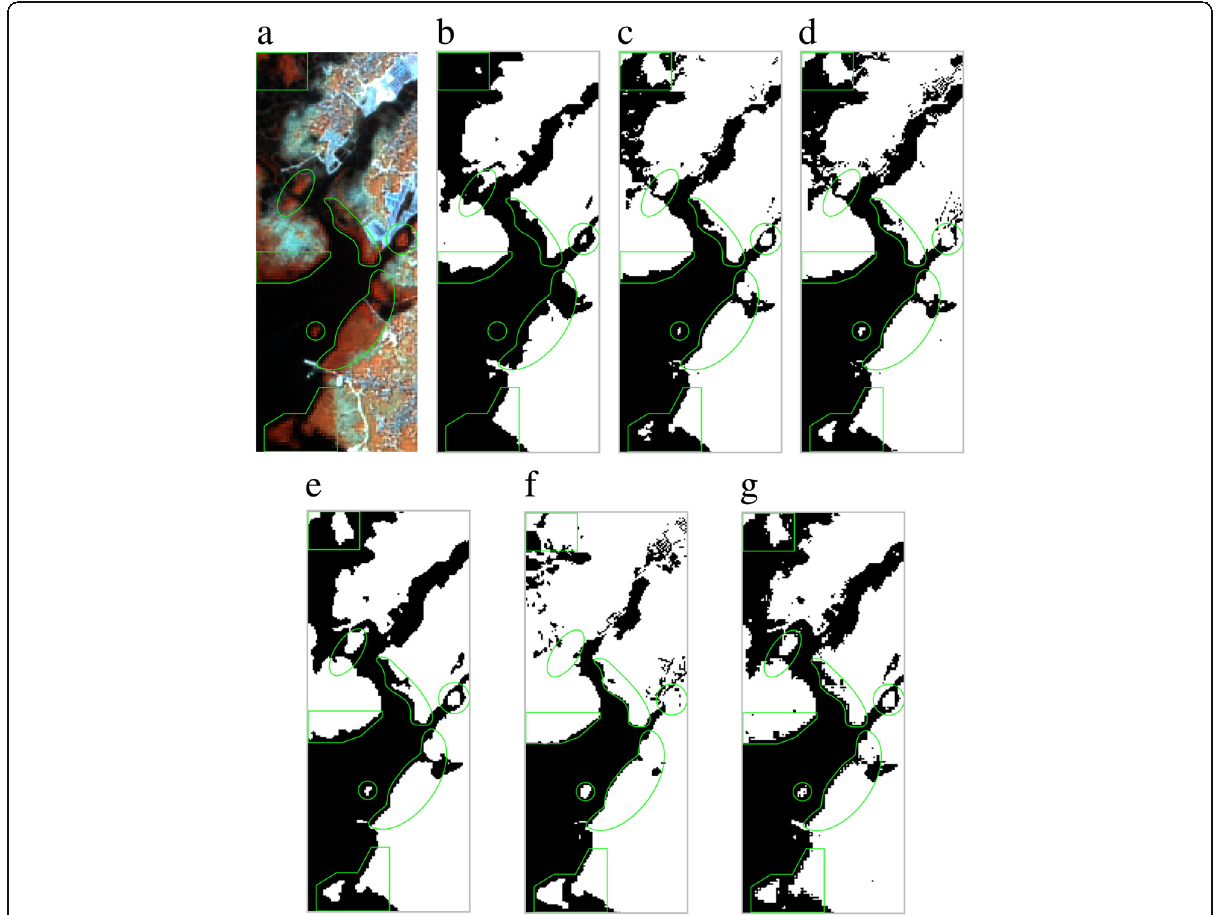
Fig. 12 Misclassification as water of tidal vegetation (mangroves, enclosed in green) as observed in a false colour composite of bands 5 – 6-7 in the water indexes of the b AWEI nsh of Feyisa et al. [16], c MNDWI of Xu [15], d NDWI of Rogers and Kearney [14], e AWEI sh of Feyisa et al. [16], f NDWI of McFeeters [13], and g NIR band based on optimum threshold